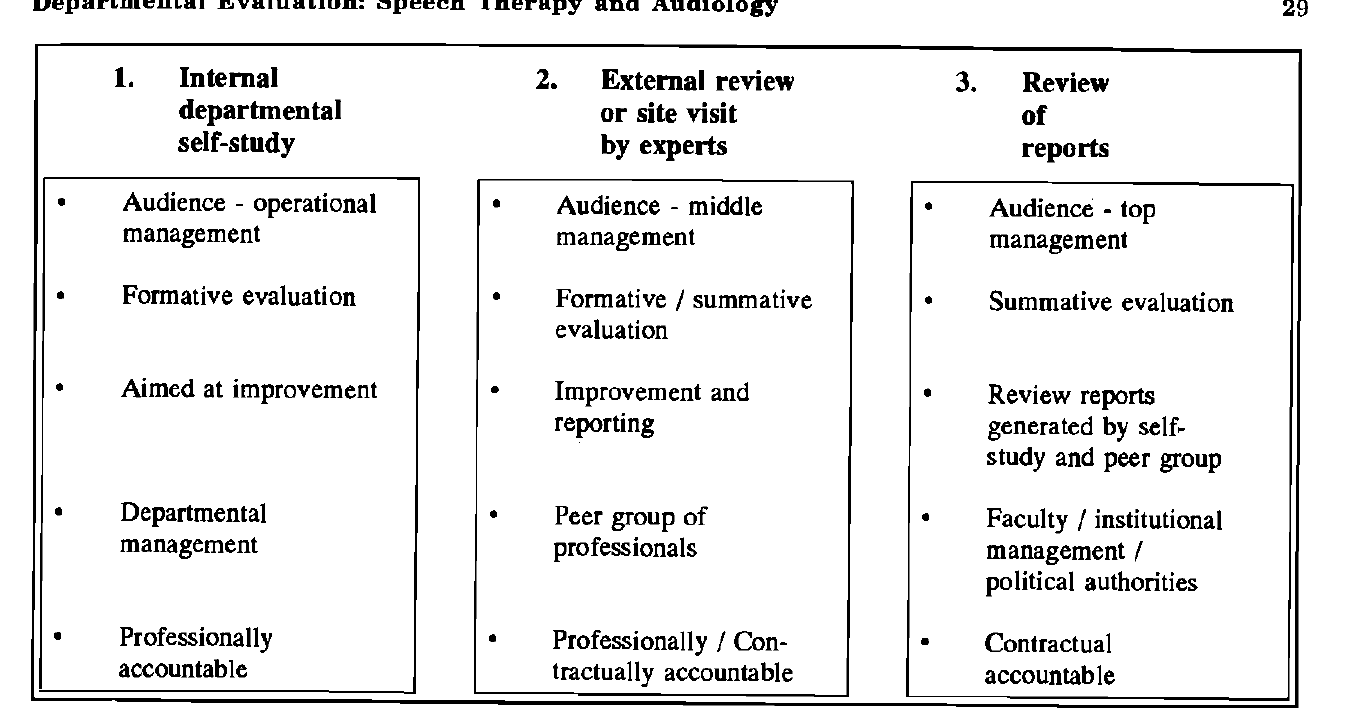
Figure 2: Management Approach to Departmental Evaluation. tional evaluation referred to in paragraph 3.1.and can be illustrated in Figure